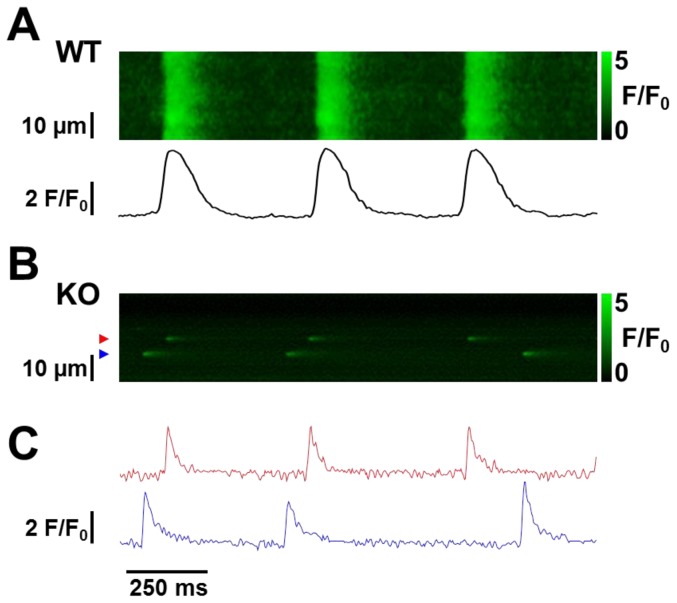
Confocal line scan images of fluo-4 loaded WT and NCX1 KO SAN cells.
A. Typical line scan from a representative WT SAN cell showing periodic spontaneous Ca transients that activate with a rapid upstroke (spatial average shown directly below the image) consistent with depolarization. B. The line scan from a representative KO cell shows no Ca transients, but Ca sparks (i.e. local Ca releases, LCRs) do occur repetitively at specific locations. C. Fluorescence traces for the locations corresponding to the two sparks shown in panel B identified using color-coded arrows.